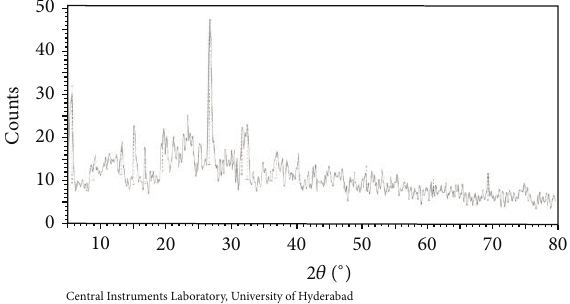
Figure 7: Powder X-ray diffraction of Co(II)